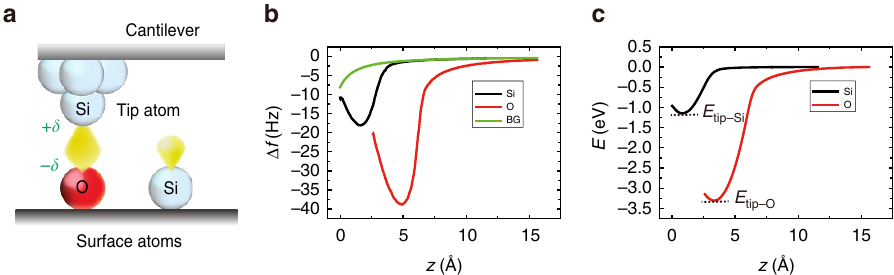
Figure 1 | Site-specific energy spectroscopy. ( a ) Schematic illustration of AFM energy spectroscopy with the polar covalent bond of Si–O. ( b ) D f curves measured on Si and O adatoms on the Si(111)-(7 (cid:2) 7) surface. The background (BG) D f ( z ) curve is also included for subtraction of the long-range component (Methods). ( c ) E ( z ) curves converted from short-range components in the D f ( z ) curves in b . Bond energies are defined at the minima of E ( z ) curves. The acquisition parameters are f 0 ¼ 152.913kHz, the oscillation amplitude ( A ) ¼ 146Å, the spring constant ( k ) ¼ 28.2Nm (cid:3) 1 and sample bias ( V S ) ¼ þ